Question: What kind of plot is shown here?
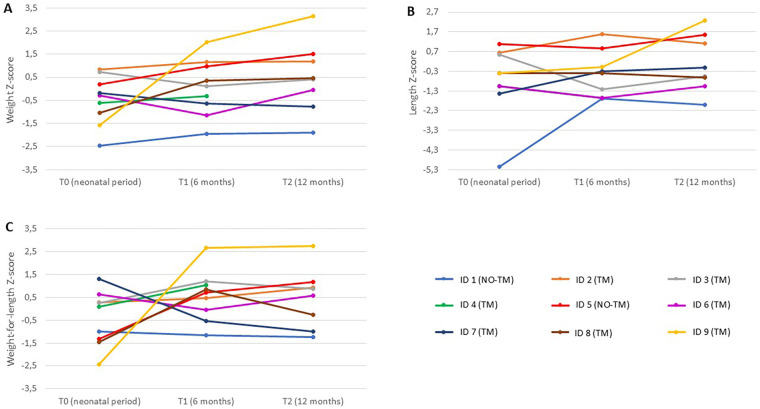
Answer: line